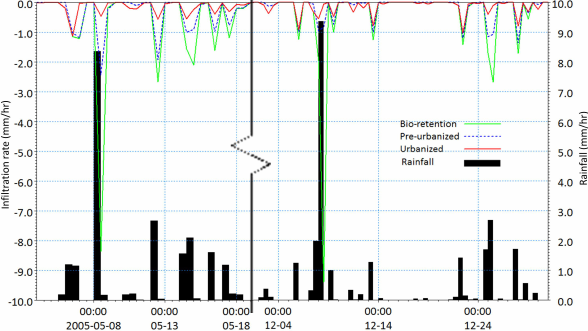
Fig. 9. Average infiltration rate of entire catchment under different